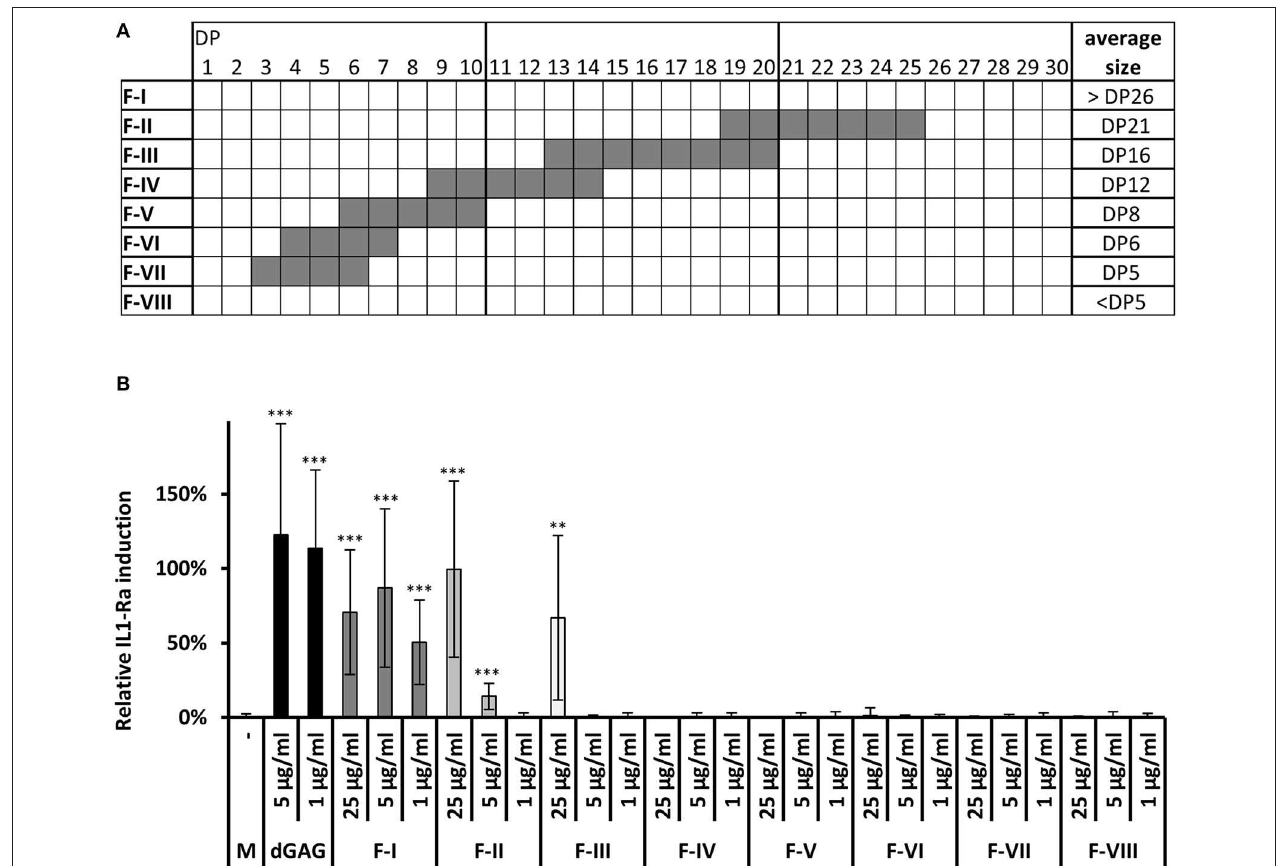
FIGURE 2 | Chemical analysis and IL-1Ra inducing activity of oligosaccharides generated by acid hydrolysis of dGAG. (A) Summerized MALDI-TOF MS analysis of fractions I-VIII. (DP, degree of polymerization; for detailed MS spectra see Figure S2 ). (B) IL-1Ra production by dGAG oligosaccharides. dGAG oligosaccharides fractions I-VIII were tested at 25, 5, and 1 µ g/ml. dGAG (5 and 1 µ g/ml) served as positive control. LPS (10ng/ml) served as external standard and were set to 100% in each biological replicate. Wilcoxon-Mann-Whitney Test: ** p < 0.01; *** p < 0.001 (compared to control, M).